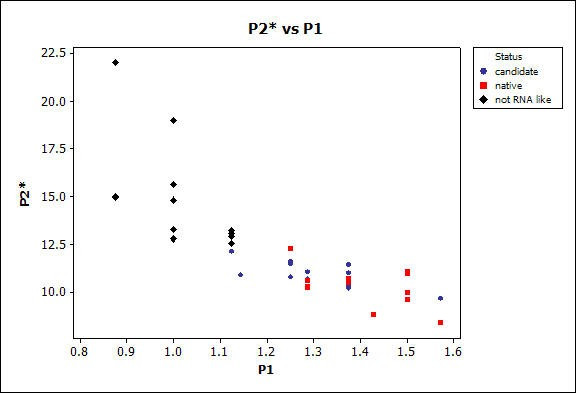
Scatter Plot for P1 vs P2*
 MathType@MTEF@5@5@+=feaafiart1ev1aaatCvAUfKttLearuWrP9MDH5MBPbIqV92AaeXatLxBI9gBaebbnrfifHhDYfgasaacH8akY=wiFfYdH8Gipec8Eeeu0xXdbba9frFj0=OqFfea0dXdd9vqai=hGuQ8kuc9pgc9s8qqaq=dirpe0xb9q8qiLsFr0=vr0=vr0dc8meaabaqaciaacaGaaeqabaqabeGadaaakeaacqWGqbaudaqhaaWcbaGaeGOmaidabaGaeiOkaOcaaaaa@2FD0@.